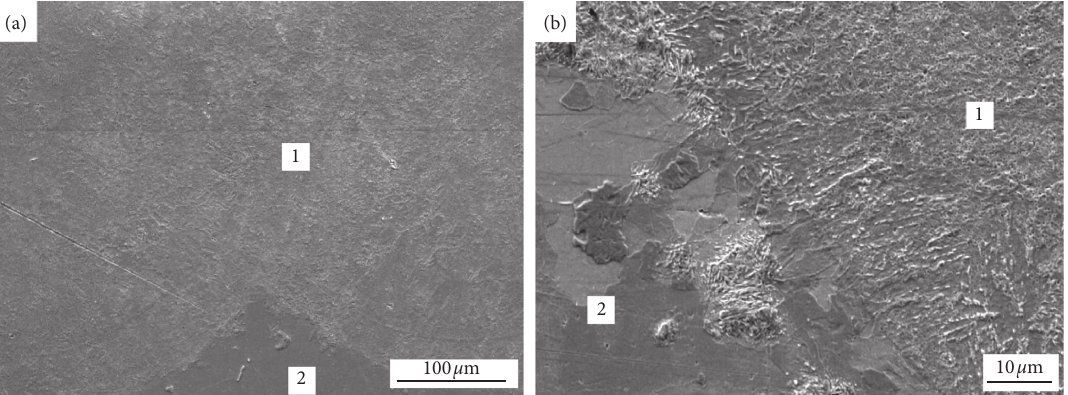
Figure 10: Microstructure in the zone of overlapping of individual tracks: (a) magnification × 250; (b) magnification × 1000; (1) surface layer after laser processing; (2) untreated zone. Table 9: Chemical compositions (by energy-dispersive X-ray spectroscopy analysis) of regions 1 and 2, Figure 9(a). Region